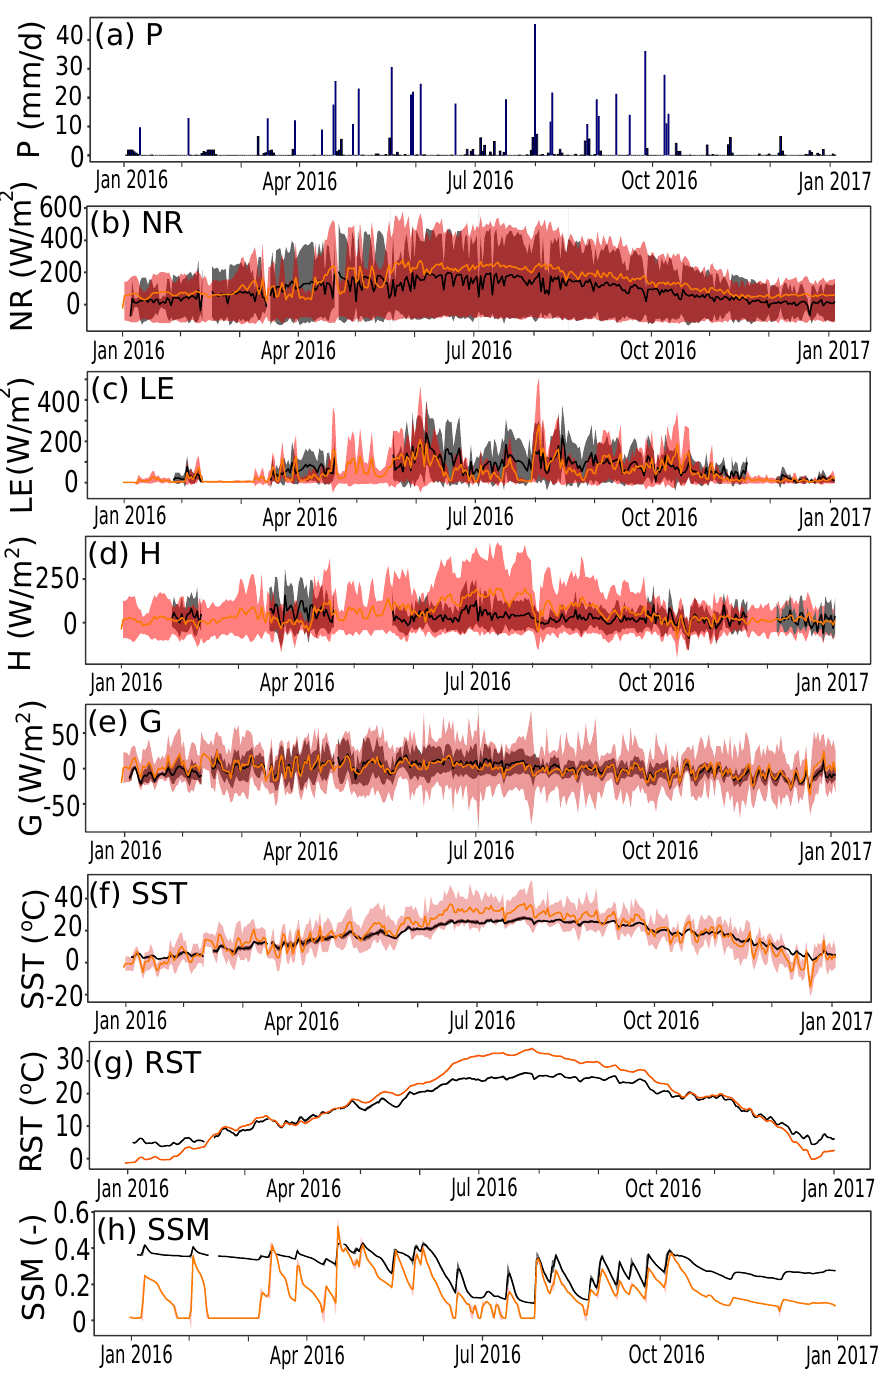
Figure 12. Daily-aggregated time series of MOISST to ARM-A32 parameter transferability experi- ments vs. observations: ( a ) precipitation (P; blue bars), and simulated (orange) and observed (black) ( b ) net radiation (NR, W/m 2 ), ( c ) latent heat flux (LE, W/m 2 ), ( d ) sensible heat flux (H, W/m 2 ), ( e ) ground heat flux (G, W/m 2 ), ( f ) soil surface temperature (SST, ◦ C), ( g ) root-zone soil temperature (RST, ◦ C), and ( h ) surface soil moisture (SSM, -). Daily standard deviation envelopes (pink for simulated and grey for observed) were added to both time series to illustrate sub-daily